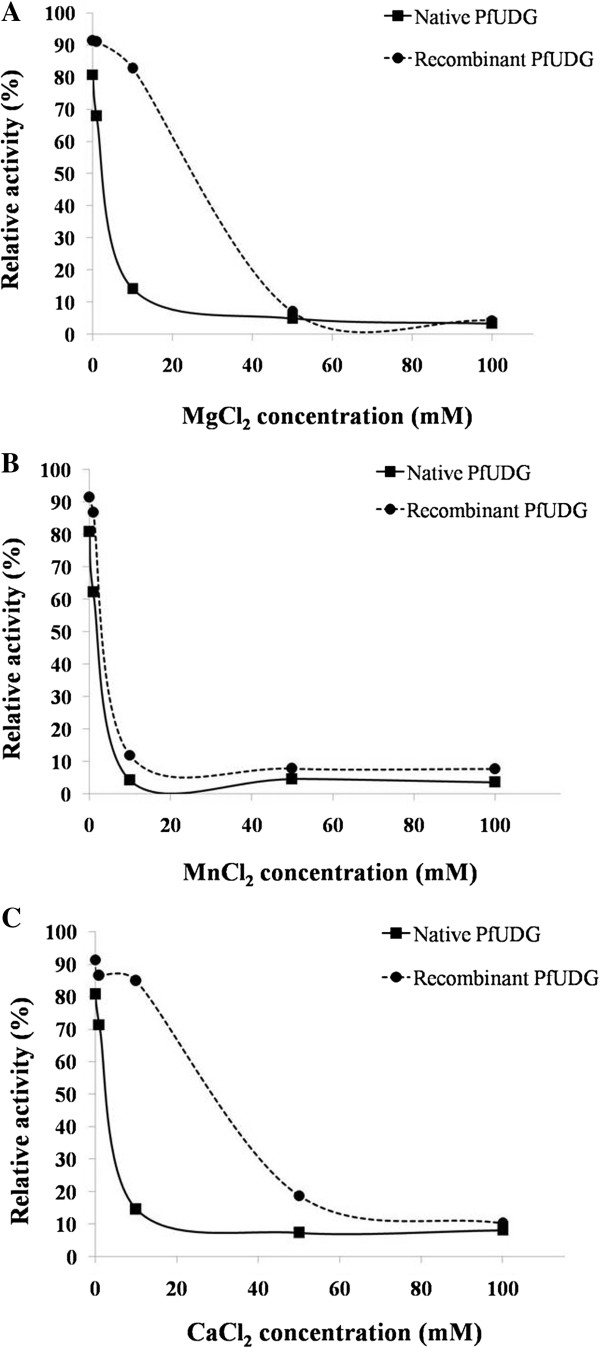
Effects of divalent cation cofactors on native and recombinant PfUDGs. PfUDG activities of native and recombinant enzymes were investigated under the assayed condition with the presence of 1, 10, 50 and 100 mM of MgCl2(A), MnCl2(B) and CaCl2(C).